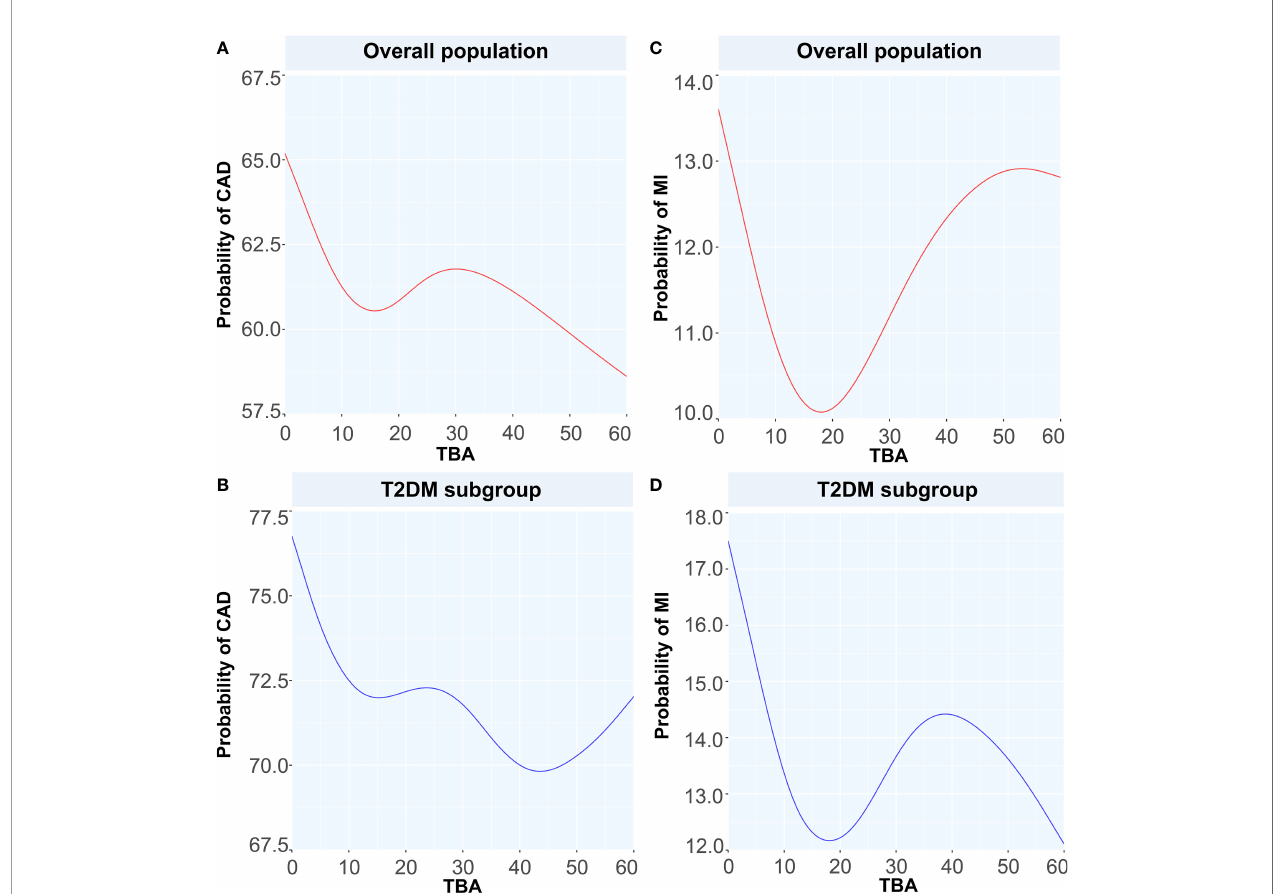
FIGURE 5 | Generalized additive modelsfor the associations between TBA and the probability of CAD and MI. Red lines represent the probability of diseases in overall population while blue lines represent the probability of diseases inT2DMsubgroup. (A) the relationship between TBA and probability of CAD in overall population, (B) the relationship between TBA andprobability of CADin T2DM subgroup, (C) the relationship between TBA and probability ofMI in overallpopulation, (D) the relationship between TBA andprobability of MI inT2DM subgroup. TBA, total bileacid; CAD, coronary artery disease; MI, myocardialinfarction; T2DM, type2 diabetes